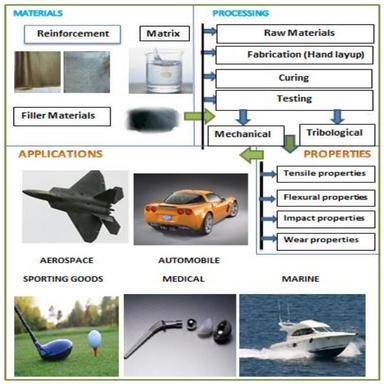
rocessing and application of hybrid composites.